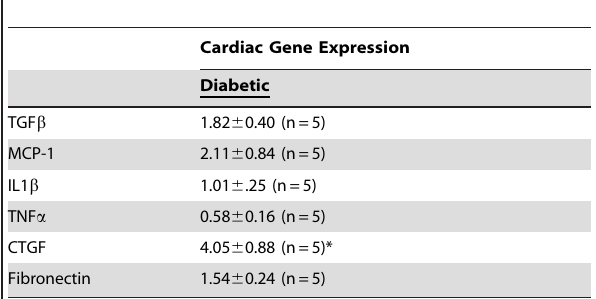
Table 4. Echocardiographic analysis. Table 5. Gene expression in cardiac